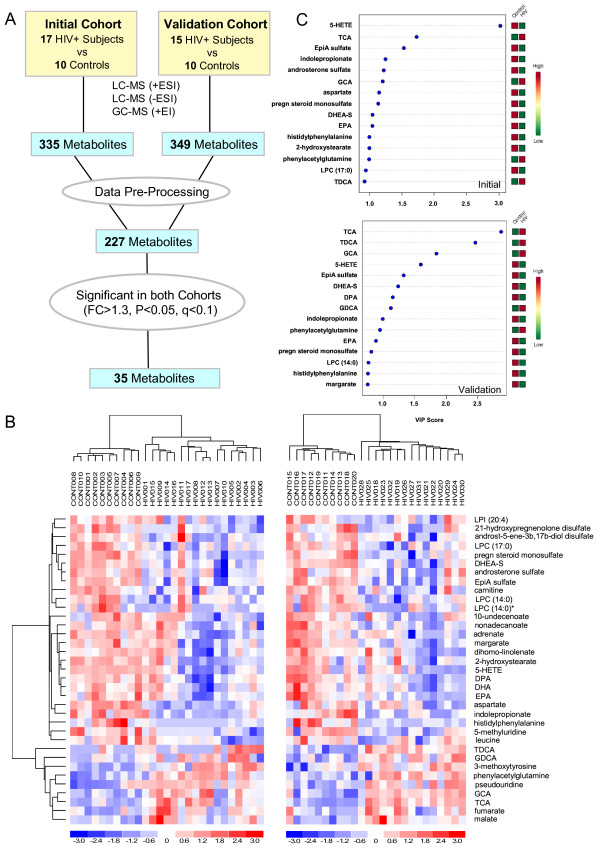
Metabolomic profiling of plasma from two cohorts identifies metabolites that distinguish HIV subjects from controls. (A) Schematic of strategy used to identify plasma metabolites altered in initial and validation cohorts. LC, liquid chromatography; GC, gas chromatography; MS, mass spectrometry; ESI, electrospray ionization; EI, electron ionization. (B) Unsupervised hierarchical clustering of signature metabolites (n=35) that distinguish HIV vs. control subjects in initial and validation cohorts (left and right heatmaps, respectively) regardless of HCV serostatus (FC>1.3, p<0.05, FDR <10%). Red and blue indicate increased and decreased levels, respectively. (C) Top VIP scores with expression heatmap from PLS-DA models. PLS-DA models were constructed with signature metabolites (n=35) from the initial and validation cohorts. Red and green indicate increased and decreased levels, respectively.